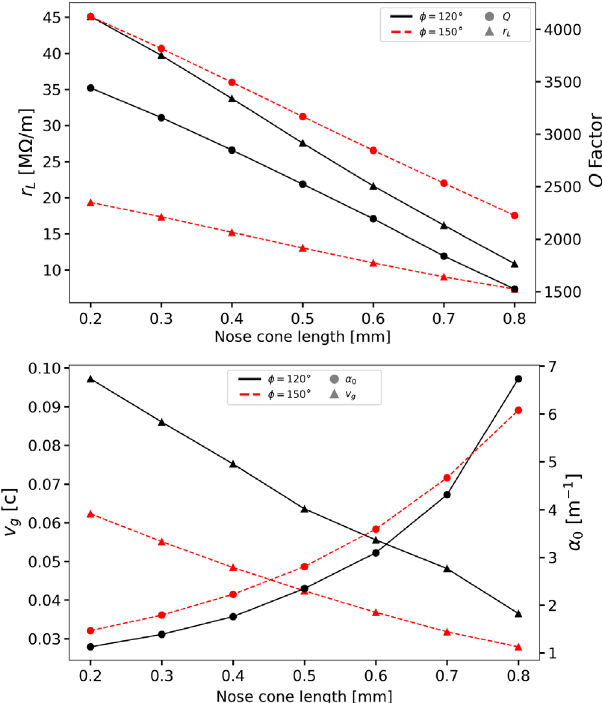
FIG. 11. Example of the nose cone ’ s optimization process for a reentrant cell option. In this case, NCH ¼ 0 . 1 mm and θ ¼ 45 °. NC